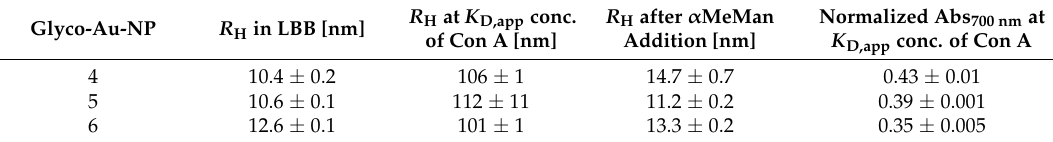
Table 3. DLS derived hydrodynamic radii ( R H ) for glyco-AuNPs in buffer medium as well as the determined R H upon exposure to K D,app concentration of Con A after 30 min and after subsequent addition of α MeMan. The values for the absorbance at wavelengths of 700 nm (normalized to absorbance at 400 nm) are an indirect measure for the particle aggregation. Error values for kinetic measurements refer to the root mean square deviation from at least three repetitive experiments. R H at K D,app conc. R H after α MeMan Glyco-Au-NP R H in LBB [nm] of Con A [nm] Addition